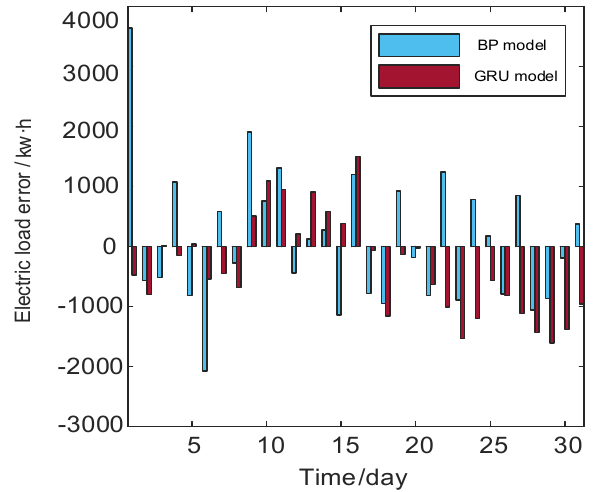
Figure 6. Comparison of prediction curves of BP and GRU models.